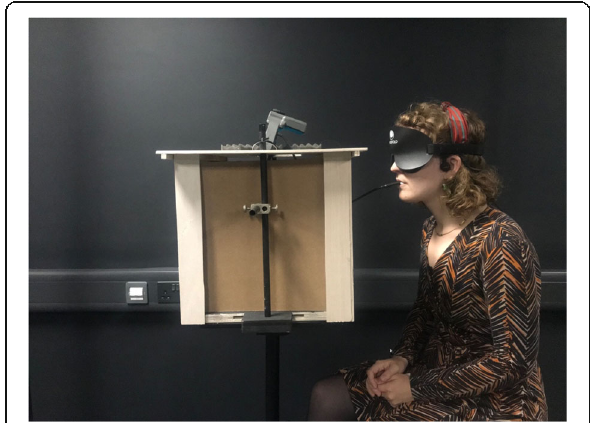
Fig. 3 Image showing a user wearing an auditory-tactile cross-modal display prototype. The tactile information is created by BrainPort, a visual-to-tactile sensory substitution device. The auditory information is created by The vOICe, an auditory-to-tactile sensory substitution device. The camera fixated within the box provides real time feed to BrainPort and The vOICe. As a result, the user can perceive the camera feed via audio, tactile and audio-tactile cross-modal